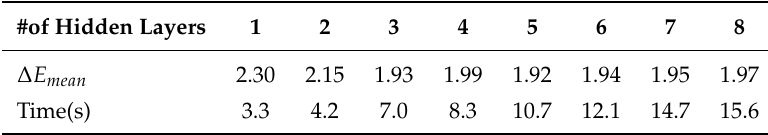
Table 2. Comparison results of different hidden